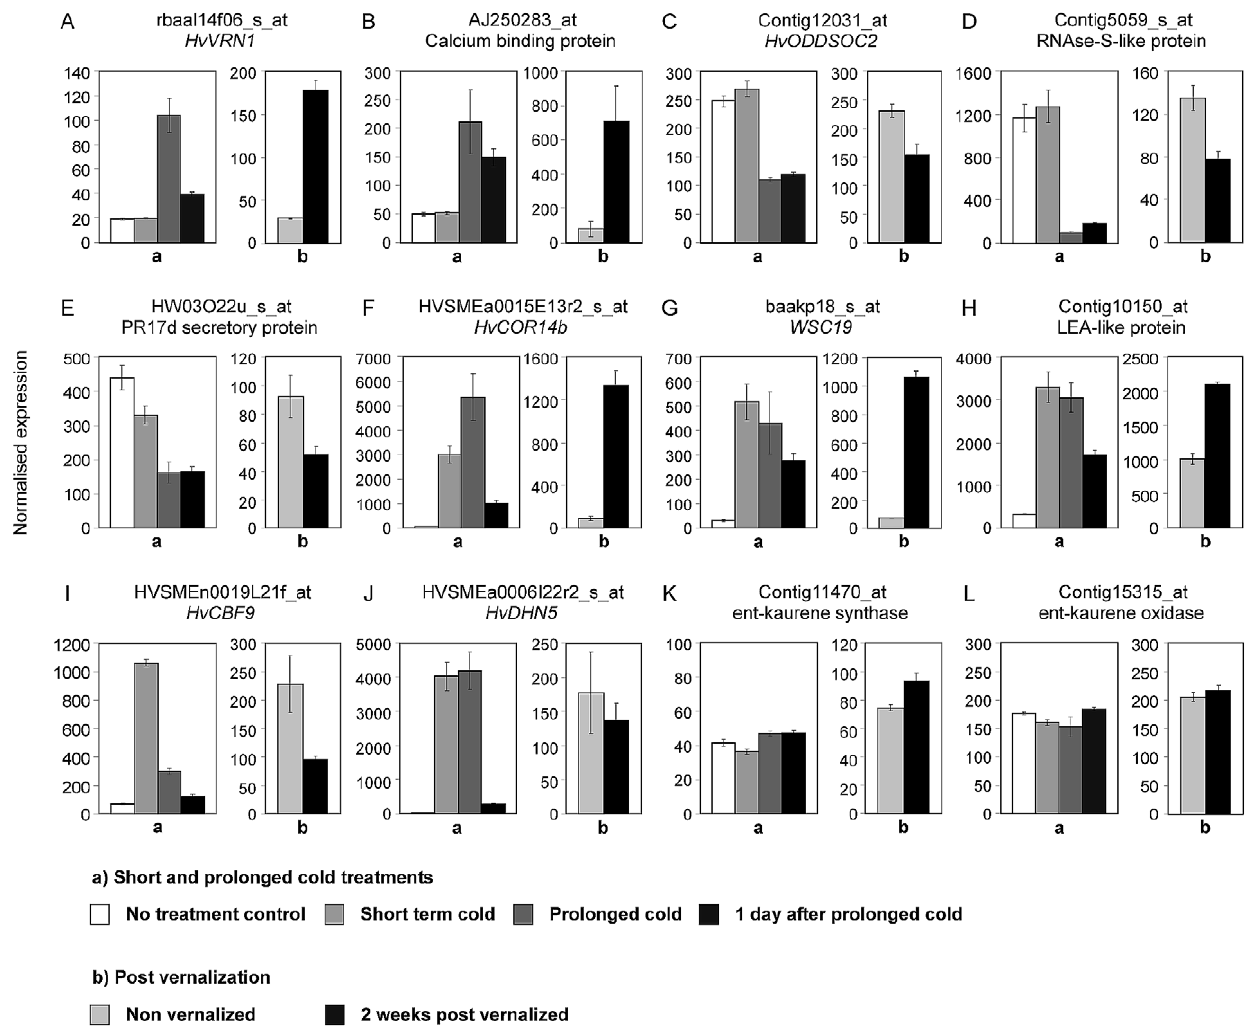
Figure 6. Examples of temperature responsive contigs. The normalized expression levels for individual contigs (A–L), as assayed by Affymetrix Barley1 Chip (RMA normalization) for control seedlings, short term or prolonged cold treatment, and one day after prolonged cold (a). Also shown are expression levels for contigs in the fully expanded second leaf of plants after vernalization (10 days post-vernalization), versus the equivalent leaves from non-vernalized control plants (b).